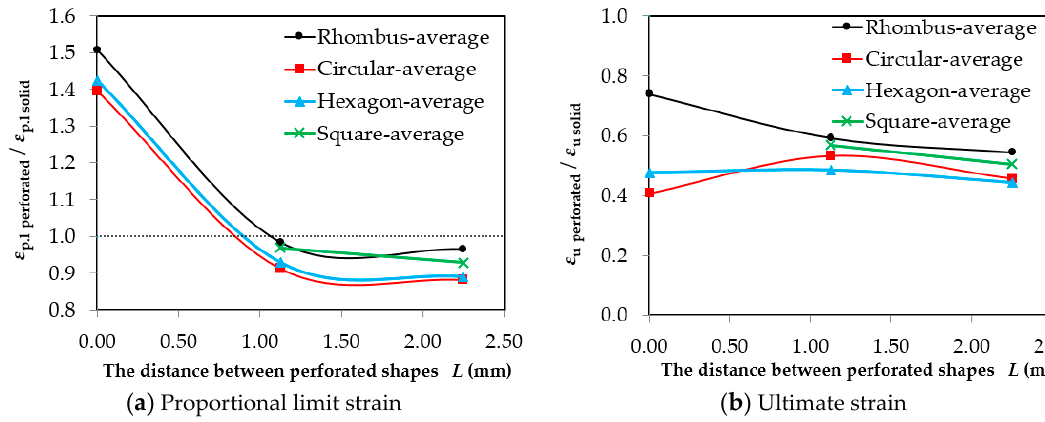
Figure 13. Relation between the ratio of perforated steel sheets strains to control solid steel sheets and the influence of the distance between perforated shapes.